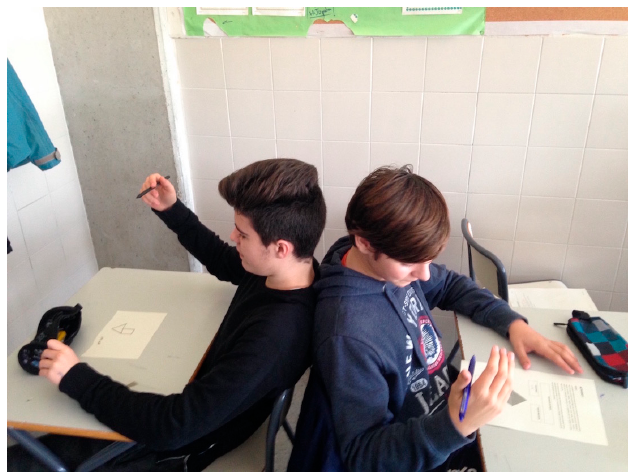
Figure 7. Students in the control group performing activity 1.